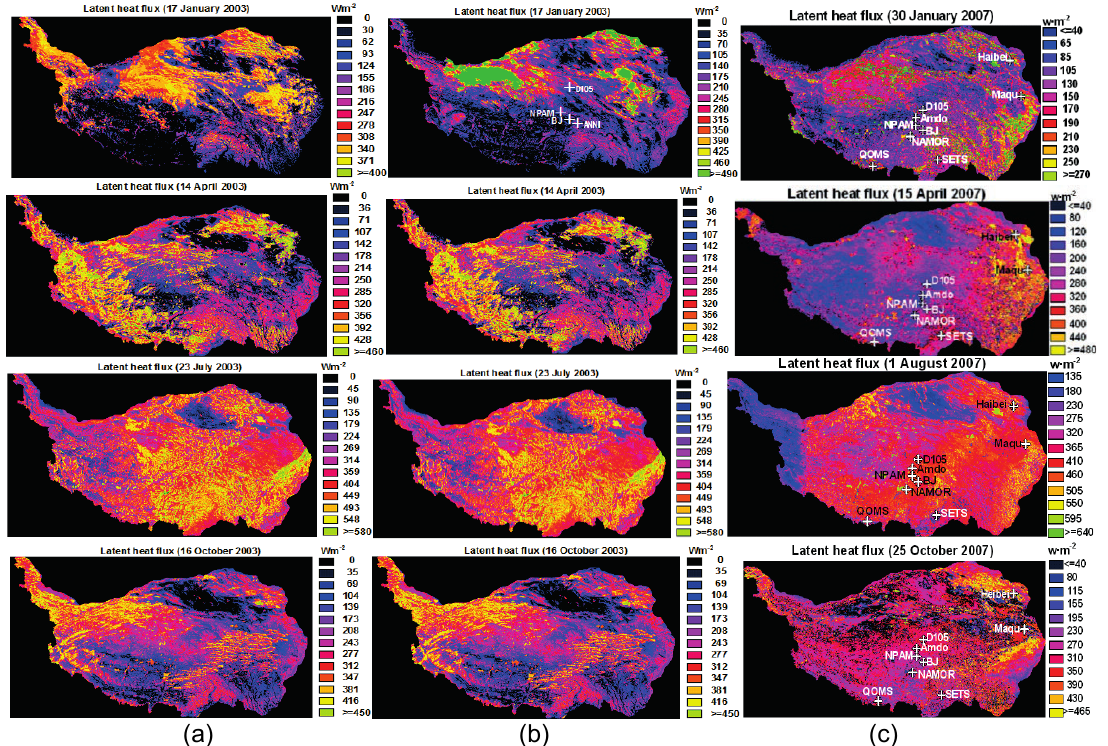
Fig. 2 Distribution maps of latent heat flux over the Tibetan Plateau area: (a) AVHRR-2003; (b) MODIS-2003; and (c)